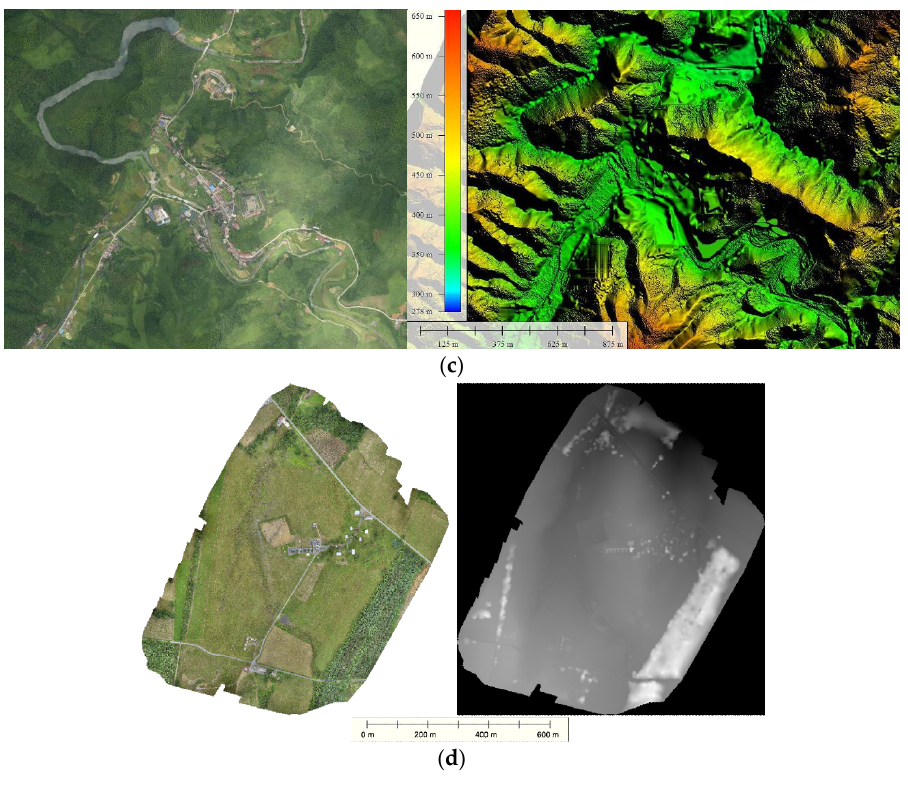
Figure 4. Digital Orthophoto Maps (DOMs) and Digital Elevation Models (DEMs) of the four datasets: ( a ) Dataset 1; ( b ) Dataset 2; ( c ) Dataset 3; and ( d ) Dataset 4 (from Pix4D [26]).